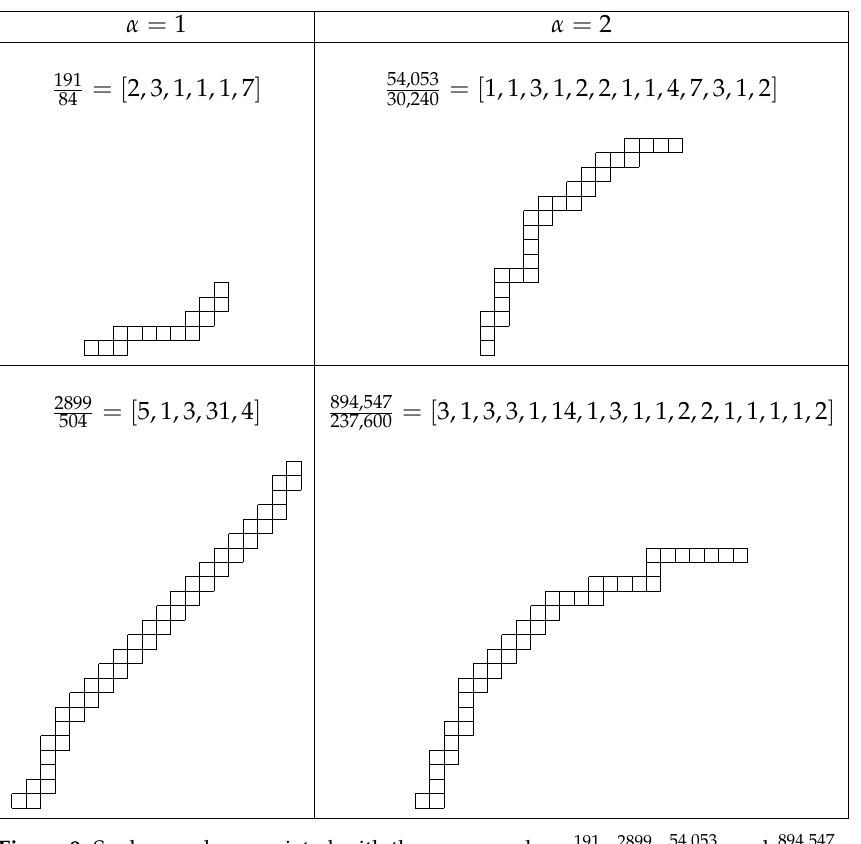
Figure 9. Snake graphs associated with the energy values 191